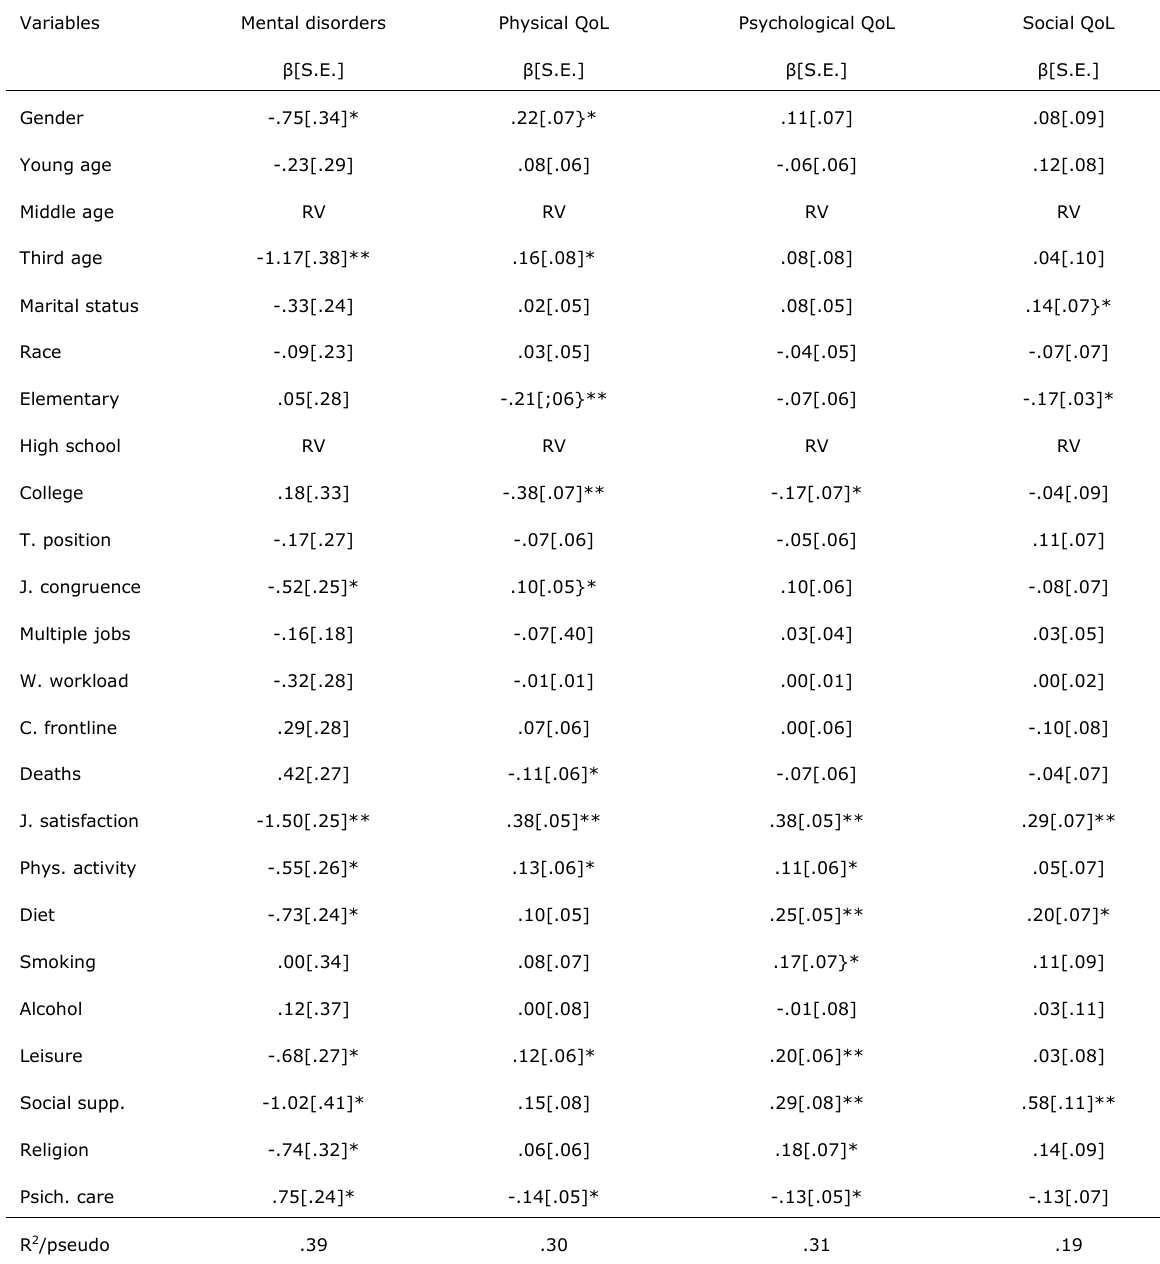
Table 4. Logistic and linear regressions of measures of quality of life and mental disorders and sociodemographic, lifestyle and labor variables